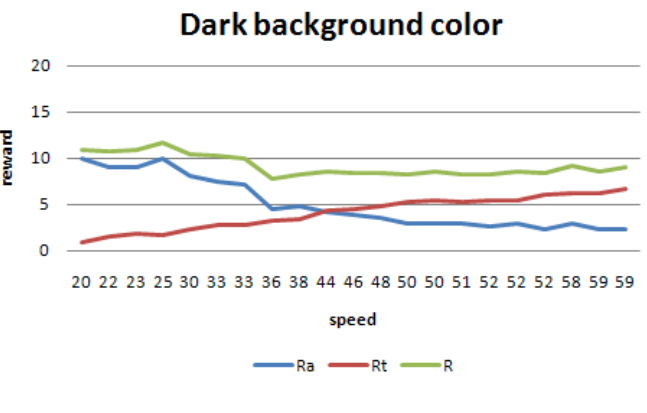
and R for dark background. a t